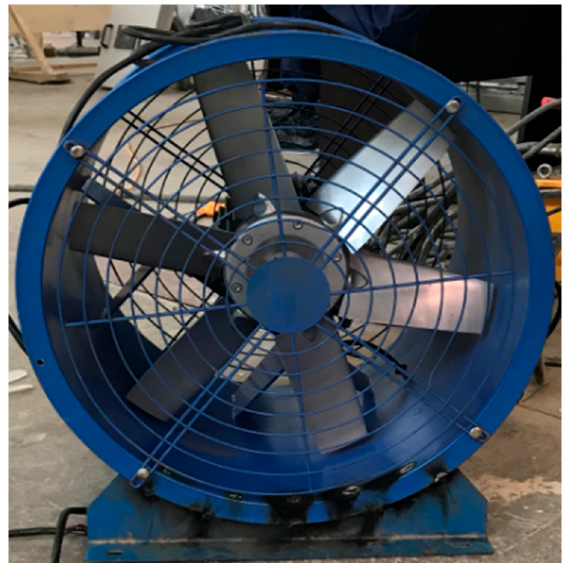
Figure 10. Photo of ZG-2 fan.